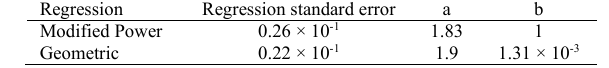
Regression Regression standard